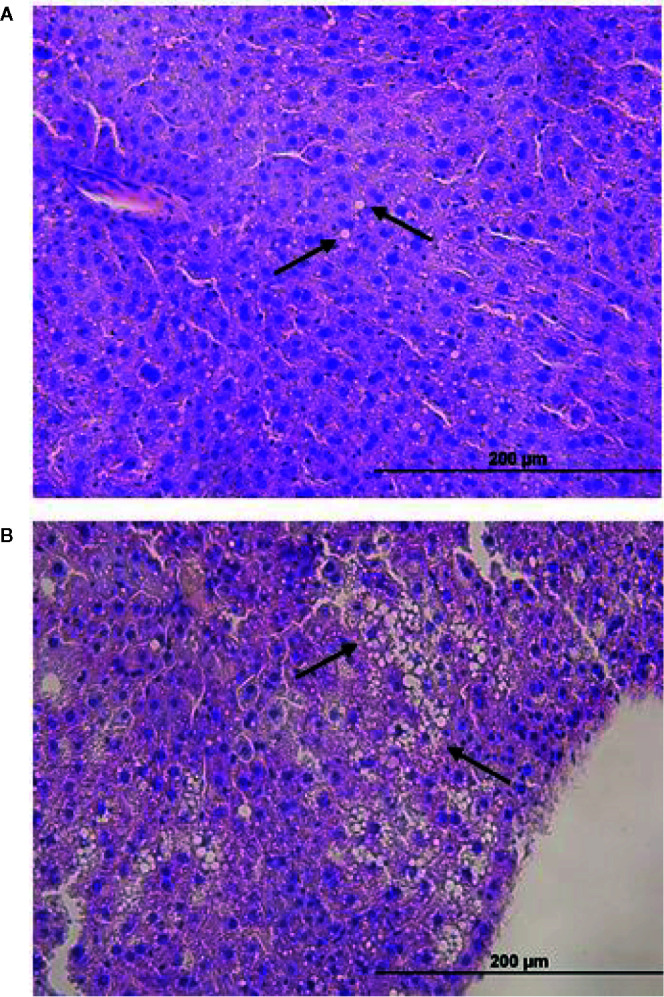
Representative H & E sections of (A) macrovesicular and (B) microvesicular steatosis in the liver (x 40 mag) of mice exposed to atrazine or control treatments from E9.5 to 12-weeks or 26-weeks of age. Arrows indicate macrovesicular and microvascular steatosis (lipid droplets).